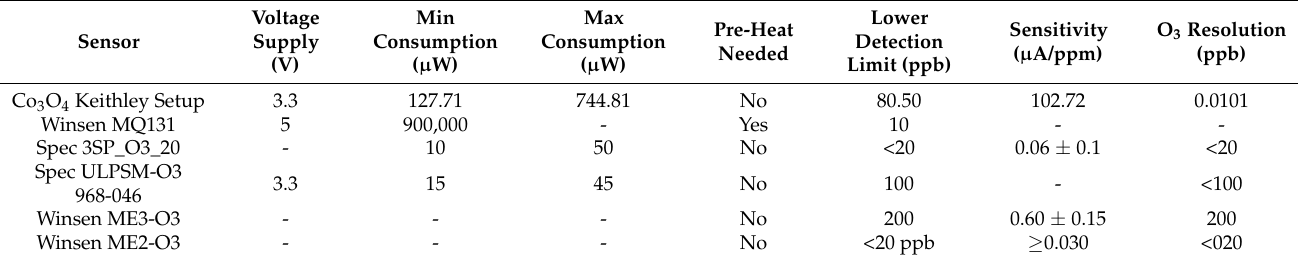
Table 2. Specifications of Co 3 O 4 and COTS ozone sensors.